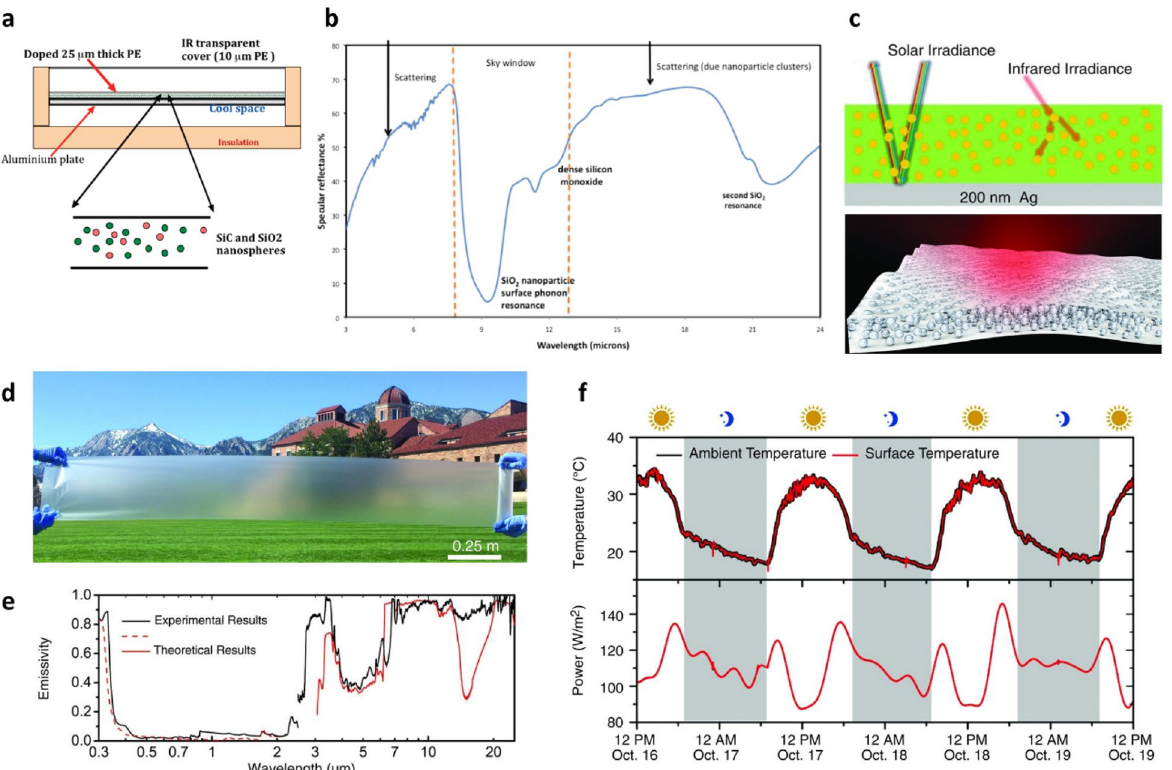
Fig. 1 PDRC films consisting of selective thermal emitters and a metal reflective layer. a Schematic of an RCM comprising SiO 2 - and SiC-doped PE films. b Measured reflectance spectra of RCMs at thermal radiation wavelengths. Reproduced with permission from [64]. Copyright 2010,